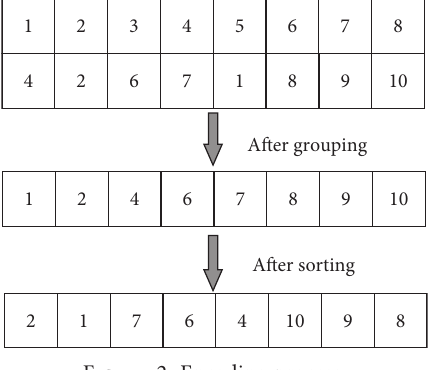
Figure 2: Encoding